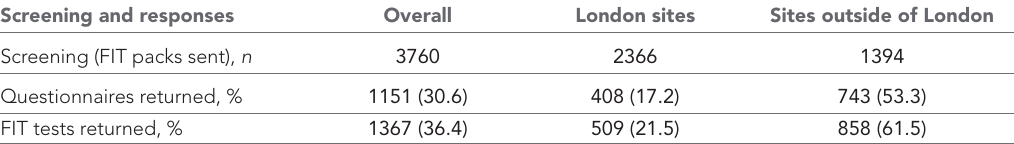
Table 3 Questionnaire response rates inside of London compared with outside of London